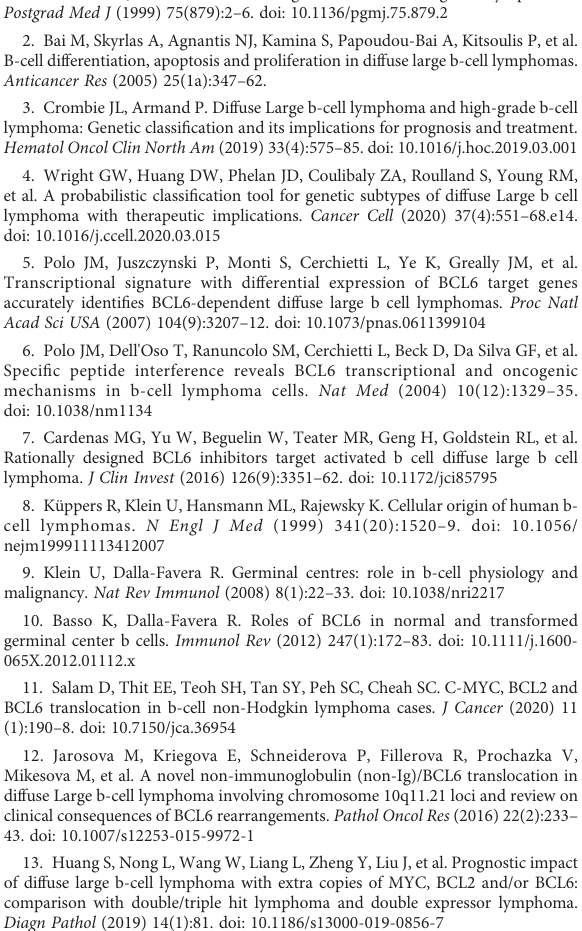
SUPPLEMENTARY FIGURE 4 In vivo pharmacokinetics and biodistribution study. The iRGD-Exo were electroporated with Alexa-647-labeled siRNA NC before injection in mice. These modi fi ed exosomes were then intravenously injected into BALB/c mice. (A) Blood samples were collected at indicated times and half-life was calculated. (B) After 72 h of injection, the liver, spleen, lung, kidney and heart tissues were collected. Tissue distribution of siRNA molecules was observed. SUPPLEMENTARY FIGURE 5 HE staining images of major organs. (A – D) H&E staining analysis of tissue sections from liver, spleen, lung, and heart tissues (Scale bar, 50 m m). The liver tissues were intact, and the hepatocytes were polygonal shape and regularly arranged. The spleen tissues had two distinguishable areas including the white pulp and the red pulp. In lung tissues, the alveoli were integrated and there was no obvious exudation in the alveoli. In heart tissues, myocardial cells were neatly arranged with clear